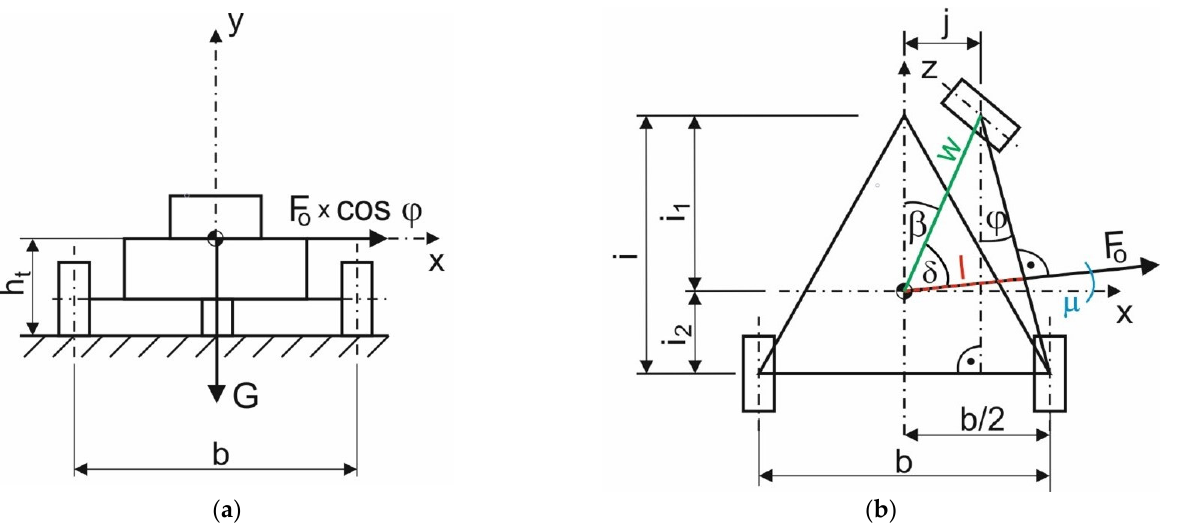
Figure 10. A calculation schema of the E3-cycle: ( a ) Back view; ( b ) Top view. The center of gravity of the E3-cycle is located under the rider’s seat; therefore, closer to the rear axle of the vehicle, in the middle, as low as possible. The E3-cycle is fitted with wheels with a 260 mm radius tire. The position of the center of gravity is 93.9 mm above the wheel centerline (Figure 11). For the sake of summing these values, the position of the center of gravity from the pad is h t = 353.9 mm.